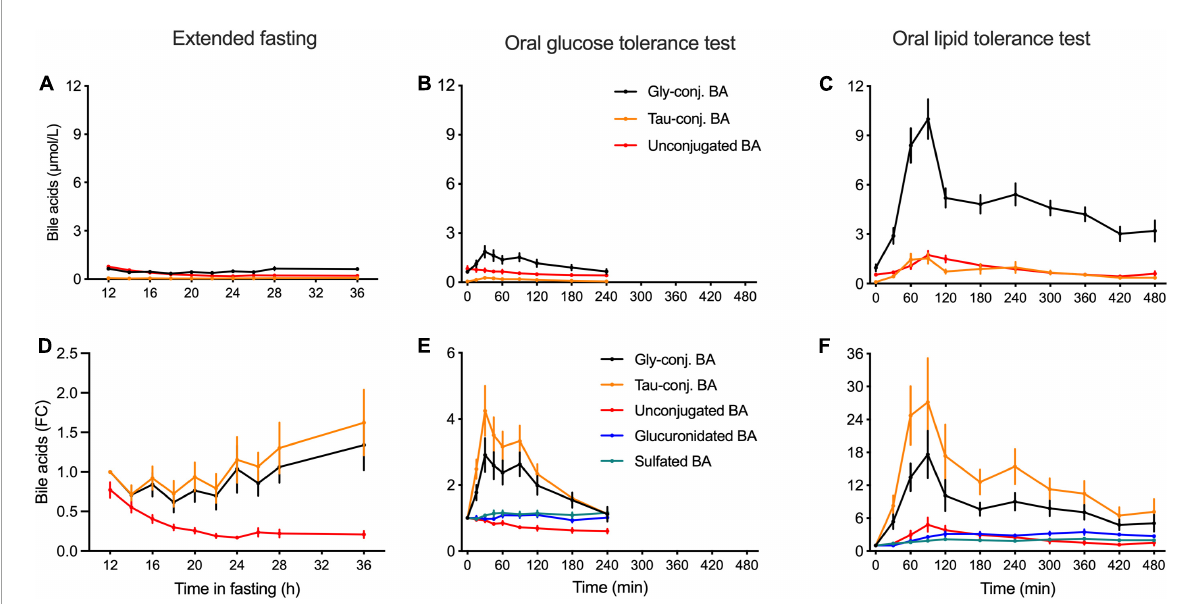
FIGURE2 Kinetics of classes of bile acids in plasma in the postprandial state and during the extended fasting period. (A–C) Plasma concentration of BA displayed as the sums of unconjugated, glycine and taurine-conjugated BA is expressed as nmol/L. (D–F) Appearances of unconjugated, glycine- and taurine-conjugated BA as well as sulfated and glucuronidated BA species are expressed as the fold-change from the baseline. (A,D) Samples from the extended fasting period. (B,E) Samples from the OGTT. (C,F) Samples from the OLTT. Data presented as mean ± SEM ( N =